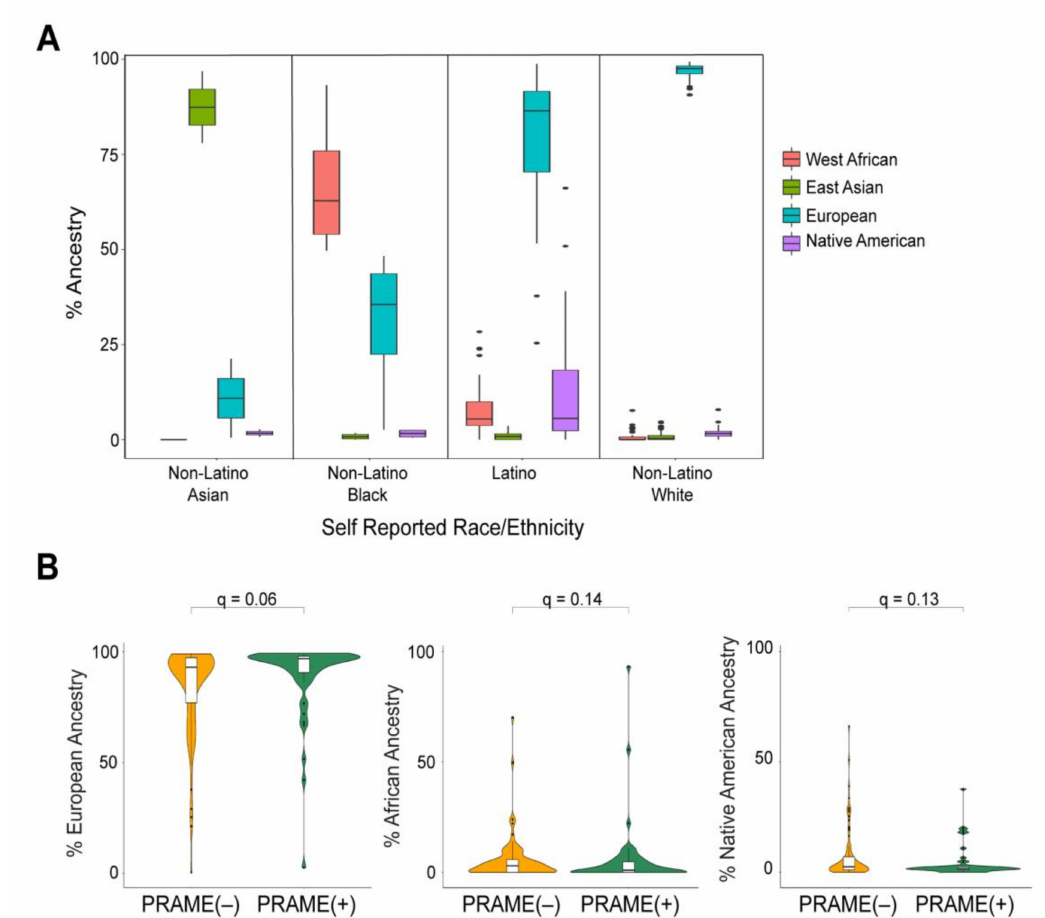
Figure 2. Global ancestral enrichment with prognostic biomarkers in UM. ( A ) Box plots of ancestral percentages of individuals grouped by their self-reported ethnicity / race. ( B ) Violin plots of ancestral percentages of patients stratified by their respective PRAME status. The q values were calculated using Wilcoxon rank sum test and adjusted for multiple